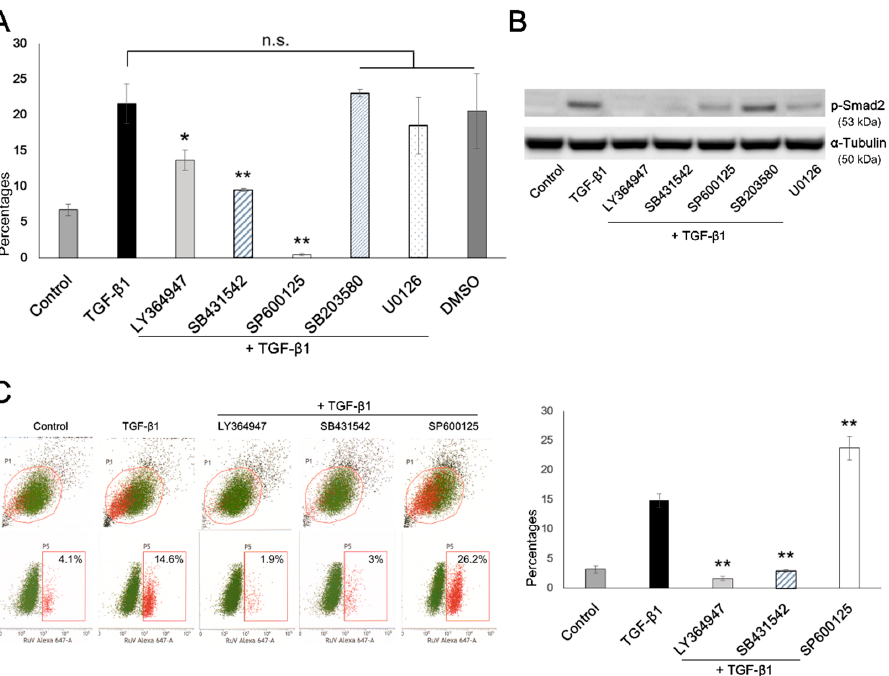
Figure 5. The TGF- β 1-induced EMT-like process enhances RuV binding and infection via Smad signaling. ( A ) Percentages of RuV-infected cells after pretreatment with TGF- β inhibitors. The cells were incubated with TGF- β inhibitors for 1 h prior to and during the TGF- β 1 treatment. After washing, the cells were infected with RuV at an MOI of 1 for 3 h in the incubator, and medium containing NH4Cl (final concentration 20 mM) was added at 6 hpi. The cells were collected and subjected to intracellular staining to detect the presence of the RuV capsid protein, as described previously. ( B ) Western blot results show changes in the p-Smad2 expression in the presence of the used TGF- β inhibitors. ( C ) Percentages of RuV-positive cells determined by FCM analysis, obtained by the virus binding assay following pretreatment with TGF- β inhibitors LY364947, SB431542 and SP600125. The A549 cells treated with one of the three above inhibitors and TGF- β 1